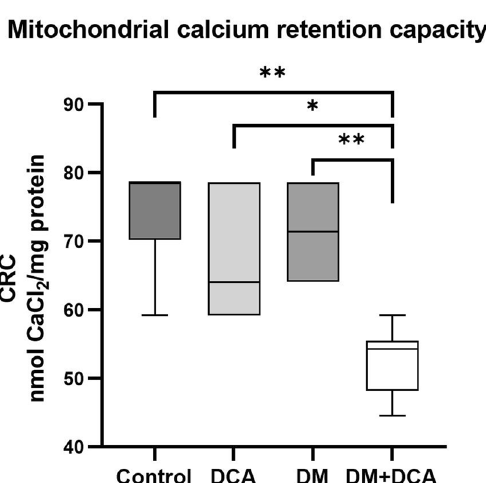
Figure 1. Mitochondrial CRC performed on isolated cardiac mitochondria using the fluorescent probe Calcium Green™-5 N—representative graphs of all experimental groups. CaCl 2 pulses (0.125 mM/injection) were added at 60 s intervals after 200 s stabilization. Ca 2+ -induced mPTP opening was observed after the fluorescence intensity increased.